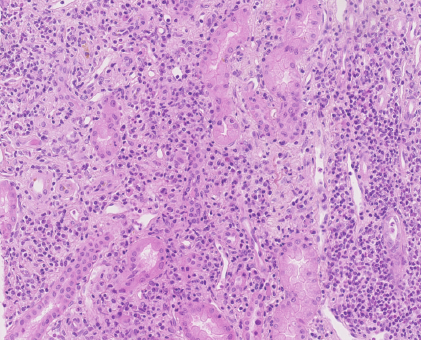
Figure 1: Kidney biopsy. Optical microscopy showed significant interstitial lymphocytic infiltration (HES).